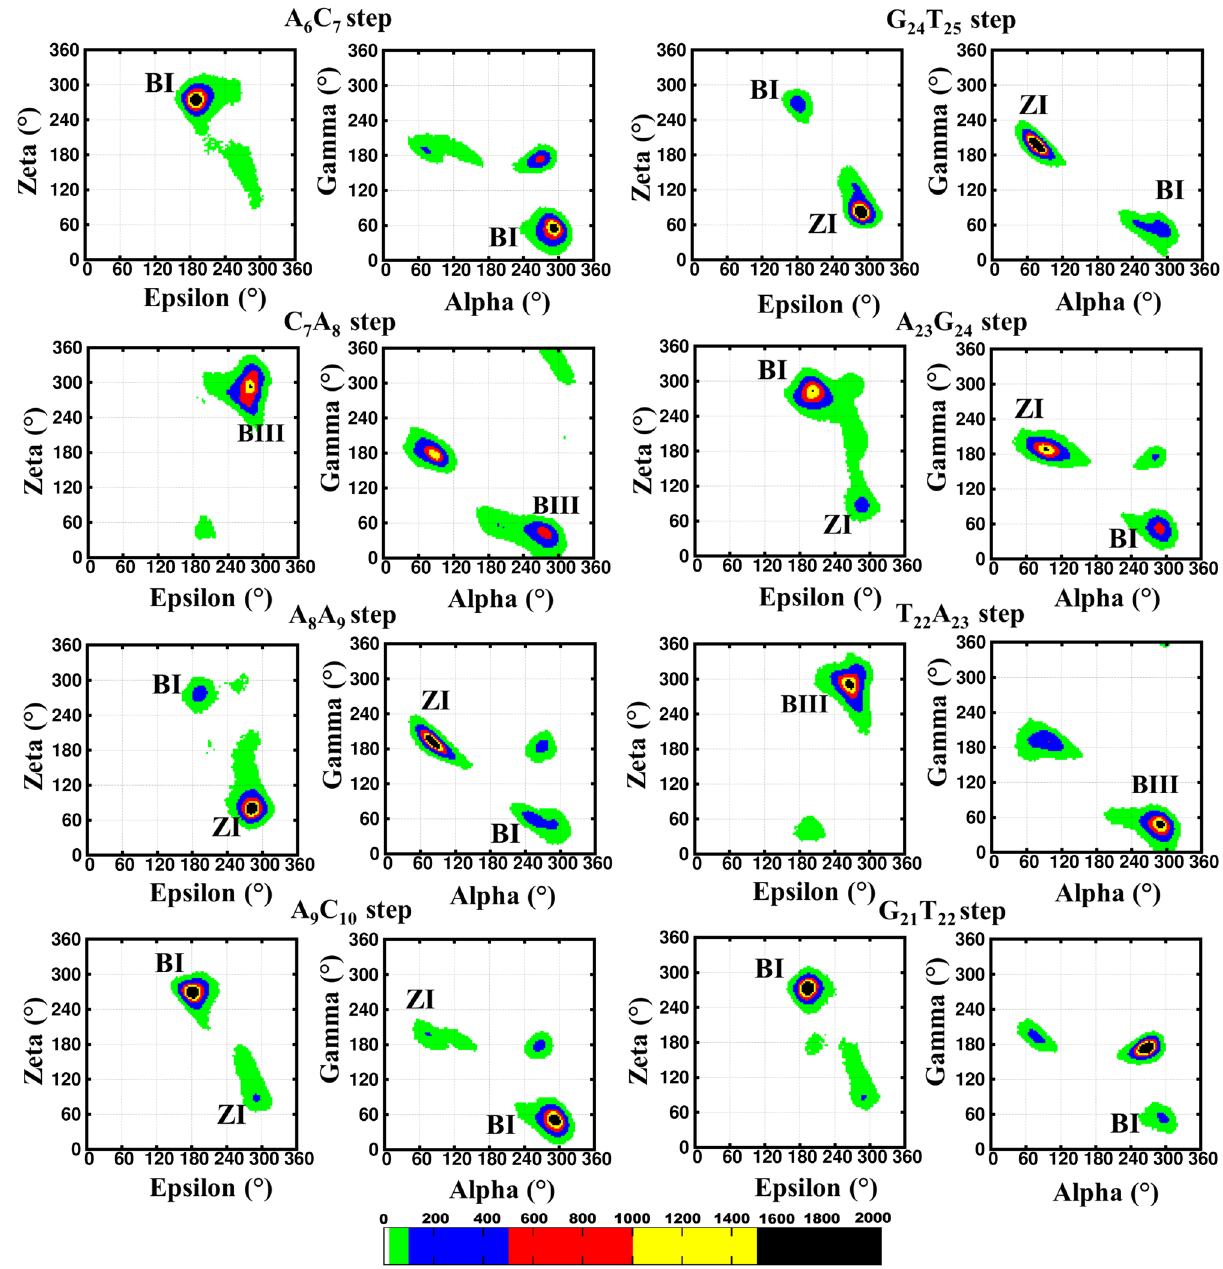
Figure 2. The backbone torsion angles (ε, ζ, α, γ) corresponding to the central pentamer that encompass A 8 (anti)…A 23 (anti) mismatch (scheme DCA-1). (ε&ζ) (1st and 3rd column) and (α&γ) (2nd and 4th column) 2D contour density plots corresponding to various steps in the vicinity of the mismatch. Note that the BI ((ε, ζ, α, γ) = (t, g − , g − , g + )), BII (g − , t, g − , g + ), BIII (g − , g − , g − , g + ) and ZI (g − , g + , g + , t) conformations are indicated adjacent to the corresponding regions. Other conformational intermediates can also be seen in the plot. The trajectories corresponding to the last 300 ns simulation is considered for the plotting. The scale corresponding to the isolines is given at the bottom. The GNUPLOT 5.2 software was used to plot the data 54 spectra have the characteristic of both the B-DNA and Z-DNA, indicative of the presence of the B–Z junction (Fig. 5A, purple arrows). In line with the CD results, 1D proton NMR spectra corresponding to schemes WC and DCA1 to DCA5 duplexes that have 0–5 A…A mismatches (Table 1, Schemes DCA-1 to DCA-5) exhibit a significant change in the proton peaks between 12 and 14 ppm. These peaks may correspond to an imino proton peak of the adenine and/or guanine and exhibit a reduction in the peak intensity due to the peak broadening when the number of mismatches increases. While the NMR spectra of d(CAA)·d(TTG) duplexes that have 0 (Scheme WC), 1 (Scheme DCA-1) and 2 (Scheme DCA-2) A…A mismatch(es) have the peaks between 12 and 14 ppm (Fig. 5B), the peak broadening is significant even to the extent of complete disappearance when the number of A…A mismatches